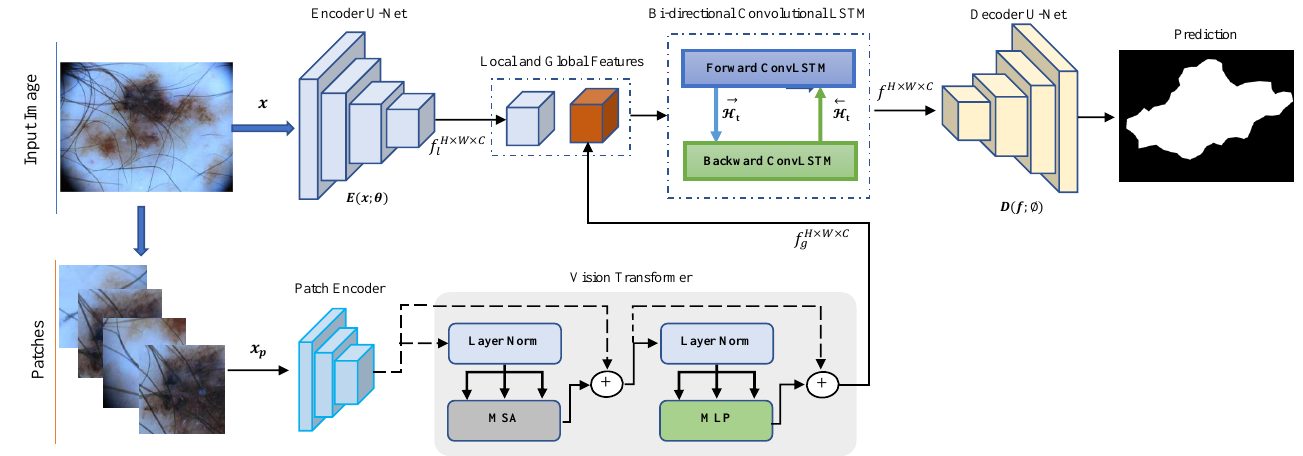
Figure 2. The structure of our proposed network for segmenting medical images. Our design offers a two parallel mechanism to capture both local semantic and global contextual representation, which are further fused using the ConvLSTM